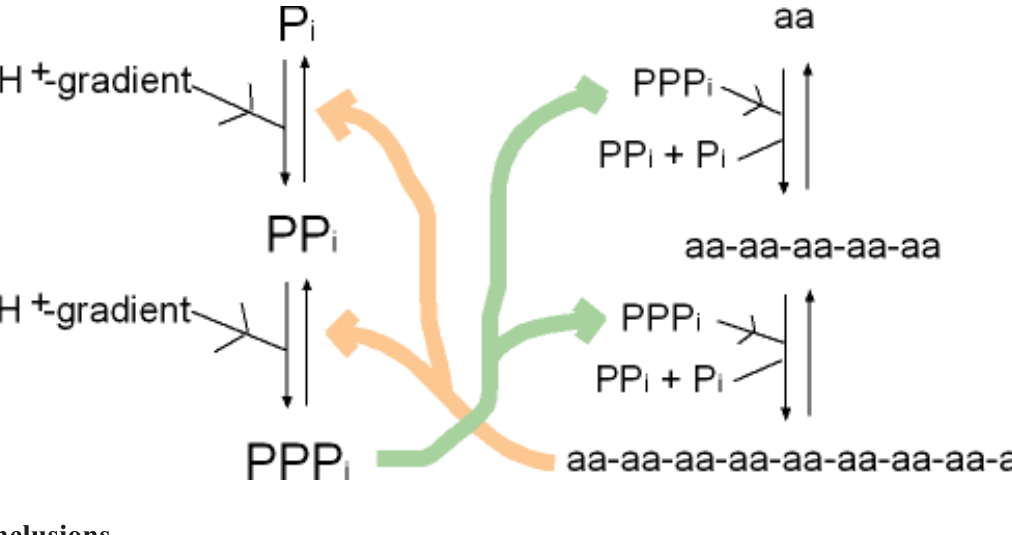
Figure 4. The synergy between short peptides and polyphosphates. Decapeptide aa-aa-aa- aa-aa-aa-aa-aa-aa-aa acts as an enzyme that, driven by a proton gradient (see Figure 1), phosphorylates phosphate to form pyrophosphate. The same enzyme phosphorylates pyrophosphate to form triphosphate. Triphosphate reacts with amino acids and phosphorylates them, giving rise to polypeptides after their dephosphorylation. In doing so triphosphate becomes hydrolyzed to phosphate and pyrophosphate. The effect is synergy between peptide and polyphosphates. Polyphosphates are required for making polypeptides which in turn catalyze polyphosphate formation. For the sake of simplicity, longer polyphosphates such as PPPPi and PPPPPi are not illustrated, but they may have played an active part in the process, just as longer peptides do